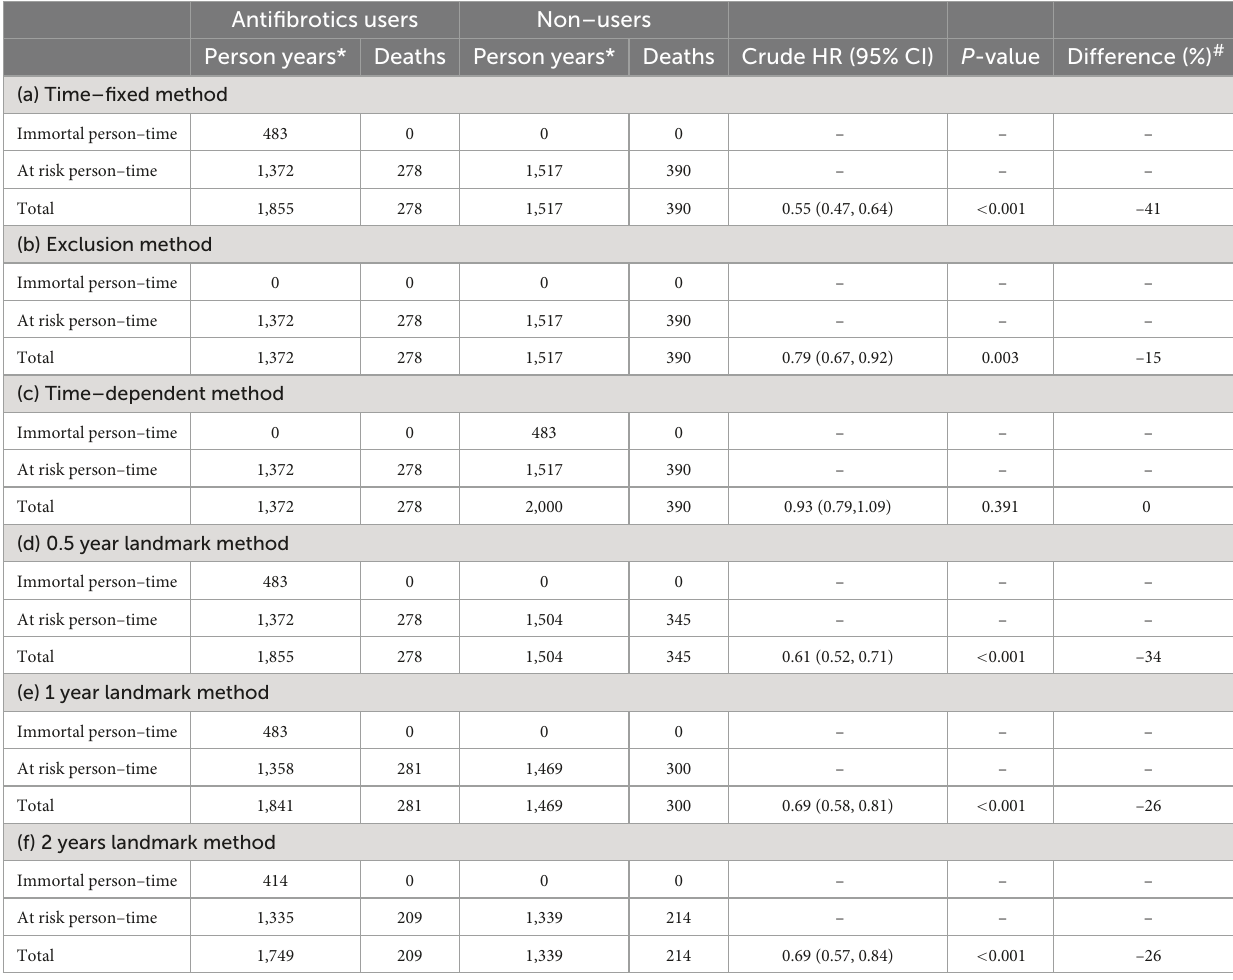
TABLE 2 An illustration of the influence of immortal time bias (ITB) on associations between antifibrotic therapy and survival in simulated subjects with idiopathic pulmonary fibrosis (IPF) using four statistical methods. Antifibrotics